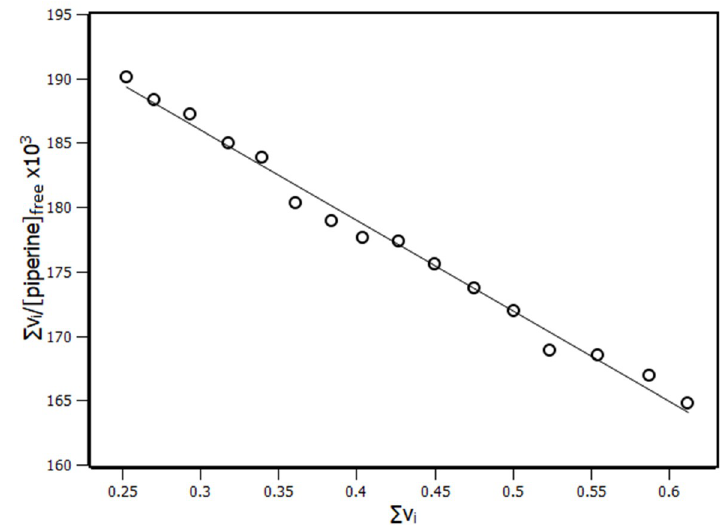
Figure 6. Scatchard plot of RSA and piperine at 288 K based on the interaction density function (IDF) model.